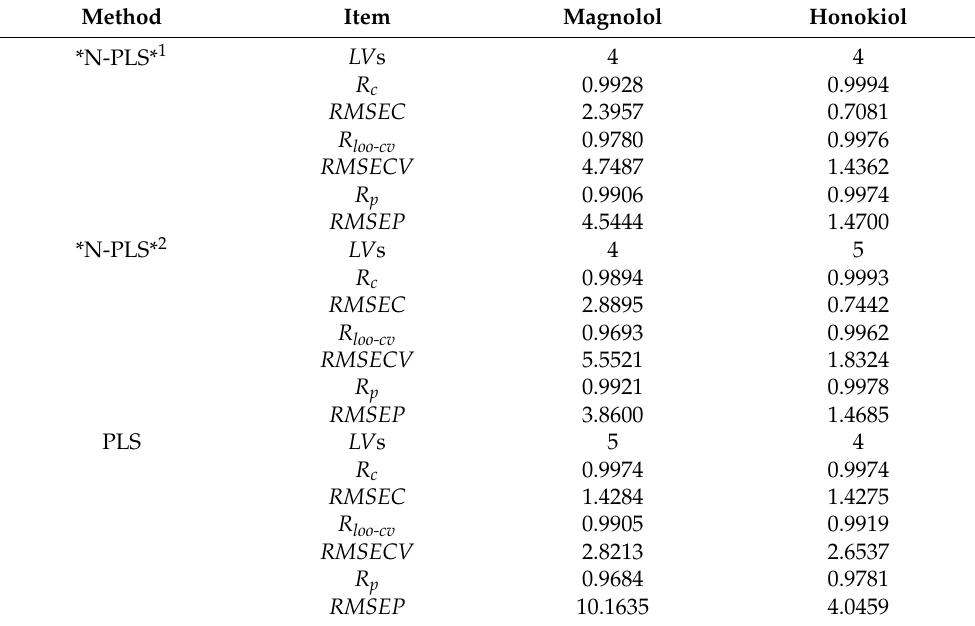
Figure 6. Plot of the experimental concentration against the calculation concentration obtained from the N-PLS method on the basis of the new constructed 3D EEM spectra for Data Set 1. A-1, A-2, and A-3 are the correlation coefficient of calibration ( R c ) for Val–Tyr–Val, Trp–Gly, and Phe, respectively. B-1, B-2, and B-3 are the correlation coefficient of prediction ( R p ) for Val–Tyr–Val, Trp–Gly, and Phe, respectively. Table 2. The statistical parameters of the N-PLS models using the new constructed 3D EEM spectra, the N-PLS models using the original EEM spectra, and the PLS models using the extracted maximum spectra in the concatenated mode of Data Set